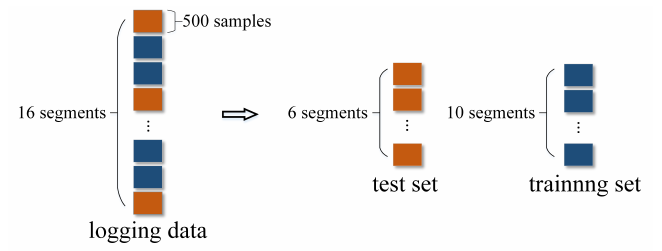
Figure 2. Dataset segmentation